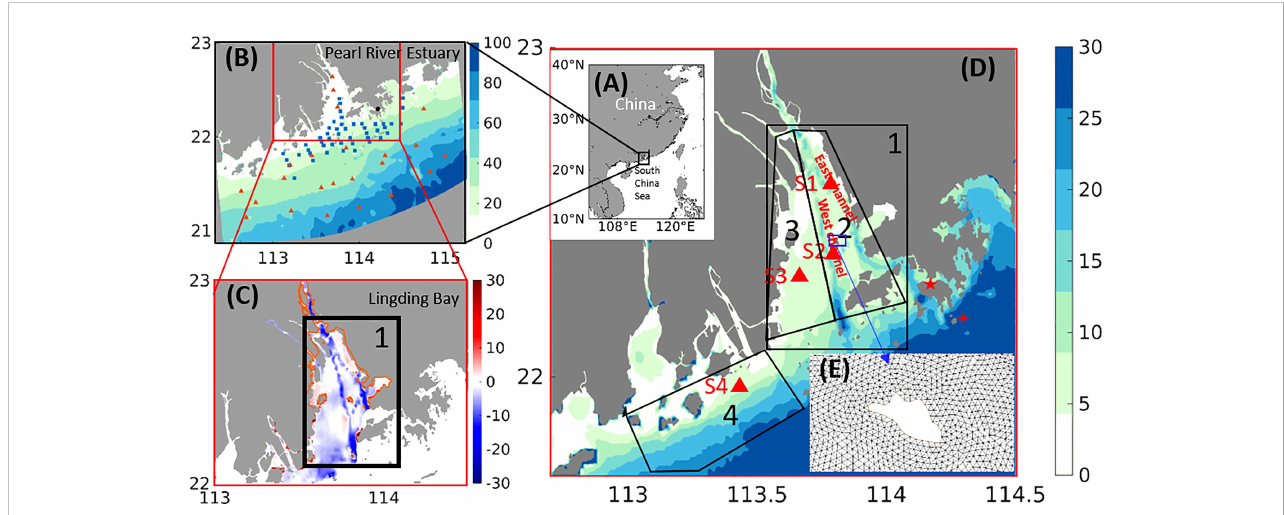
FIGURE 1 Location maps. (A) The location of the Pearl River Estuary in south China. (B) The model domain. Squares represent sites for salinity validation; triangles represent sites for temperature validation; the black dot is the location of the tidal gauge. (C) Bathymetric change from the 1970s to 2010s. The black frame indicates the Lingding Bay. The orange line refers to the shoreline in the 1970s. (D) Bathymetry (unit: m) of the PRE in 2010s, the marksed areas are: Zone 1 (Lingding Bay), Zone 2(channels), Zone 3 (west shoal), and Zone 4 (river plume dominated area). The four red triangles indicate the selected sites which are used to assess the stability of strati fi cation. The fi ve-pointed star indicates the location of Victoria harbor. The four-pointed star indicates the location of Waglan Island. (E) An example of computational grid around small